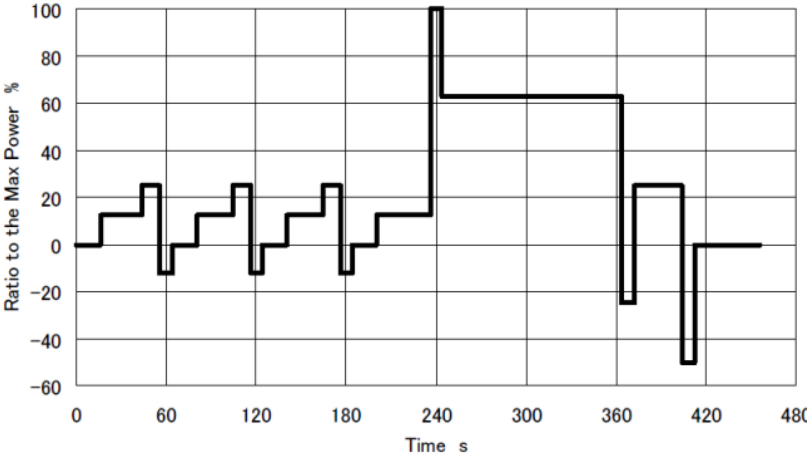
Figure 11. IEC micro-cycle for battery electric vehicle (profileB) [ 27 ] .